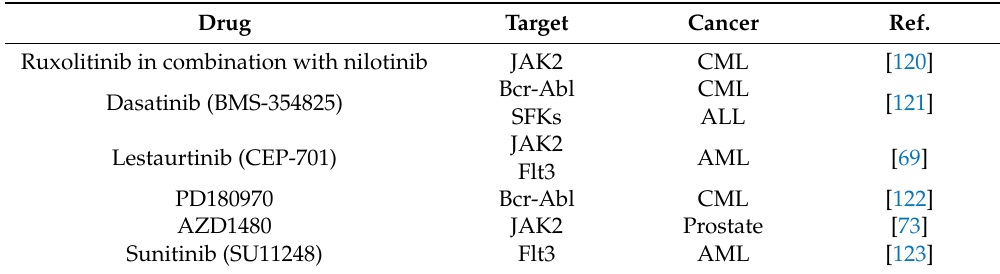
Table 3. Tyrosine kinase inhibitors (TKIs) that can indirectly target